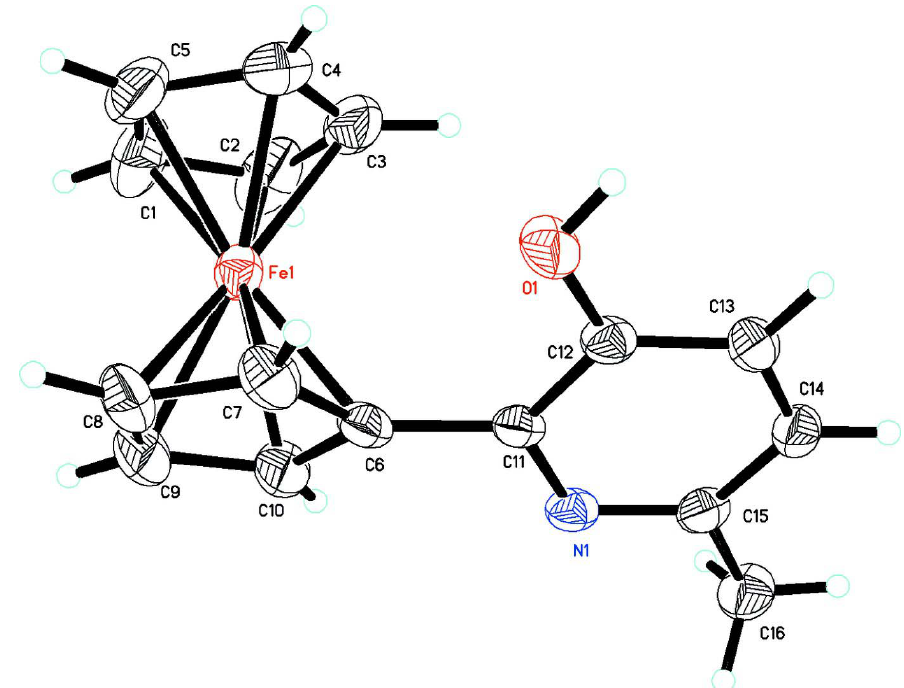
Figure 1 The molecular structure of the title compound with displacement ellipsoids at the 30% probability level. Only one disordered component of the methyl group is shown.